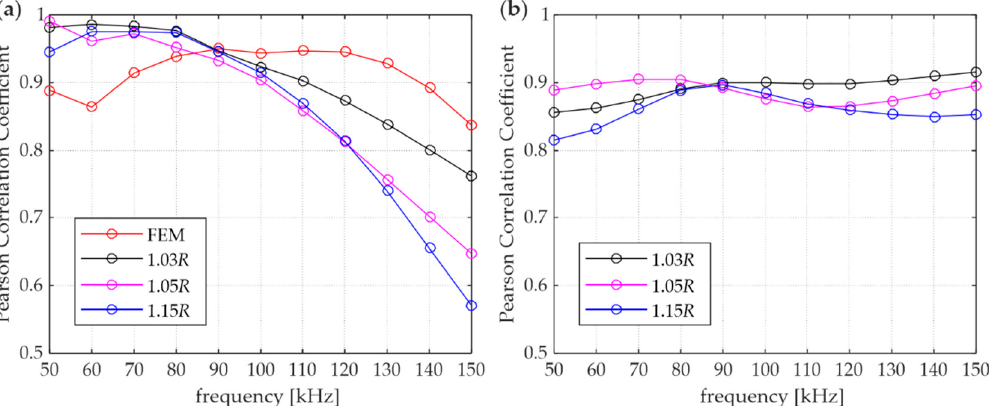
Figure 8. Pearson correlation coefficient in relation to excitation frequency: ( a ) FEM and DEM vs. experimental results, ( b ) DEM vs. FEM results.